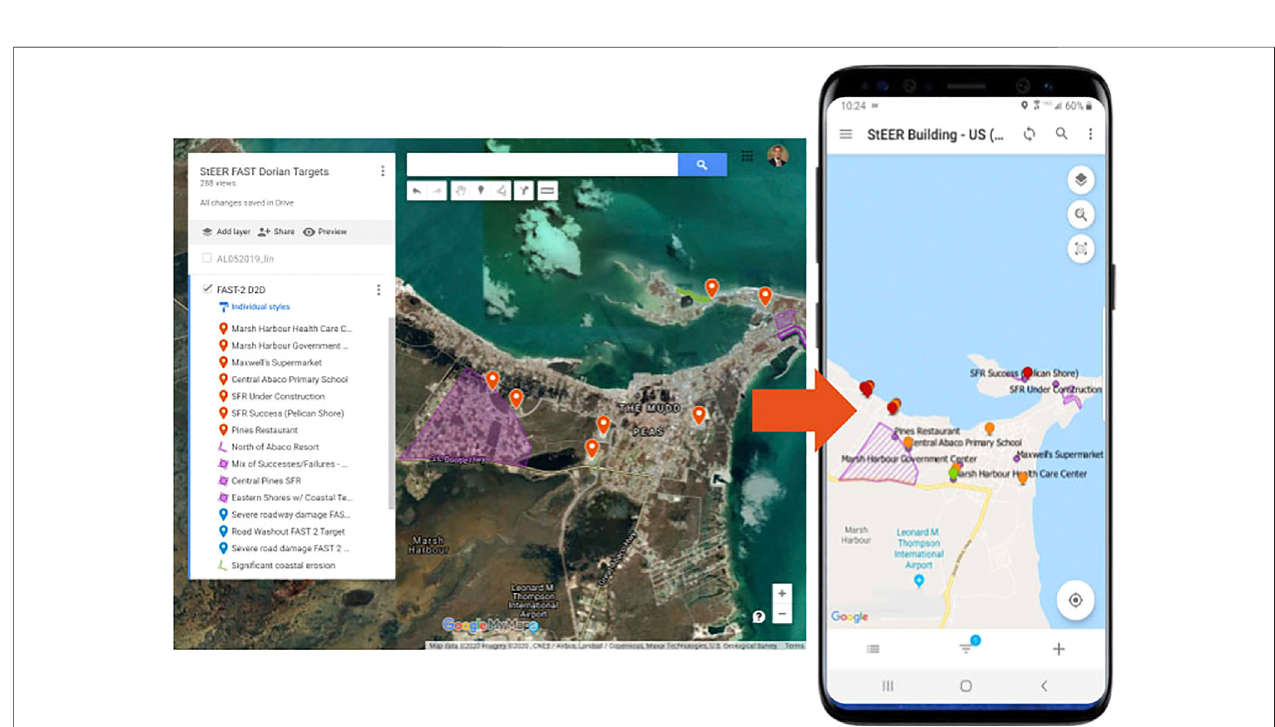
Frontiers in Built Environment |